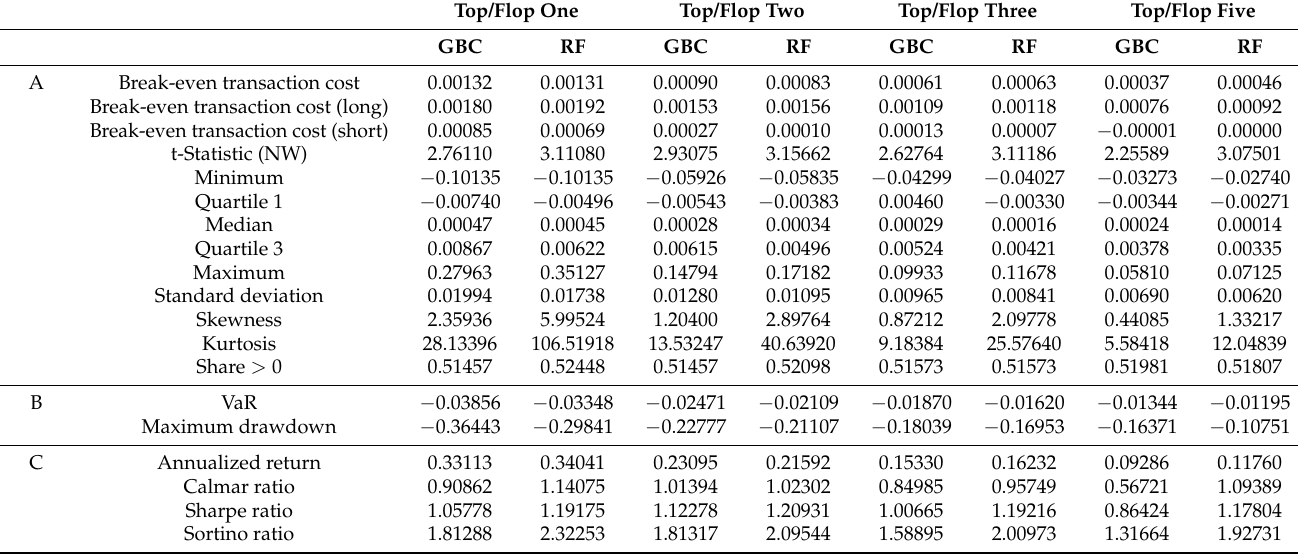
Table 2. Strategy performance for variations in the number of traded futures. Daily return characteristics (Panel A), daily risk characteristics (Panel B) and annualized risk-return metrics (Panel C) for the gradient-boosting classifier (GBC) and random forest (RF). Performance characteristics are illustrated for the top/flop one ( k = 1 ) , top/flop two ( k = 2 ) , top/flop three ( k = 3 ) and top/flop five ( k = 5 ) trading strategies and a holding period of one day ( h = 1 ) . NW denotes Newey–West standard errors with one-lag correction. VaR is calculated at the 95.0 percent confidence